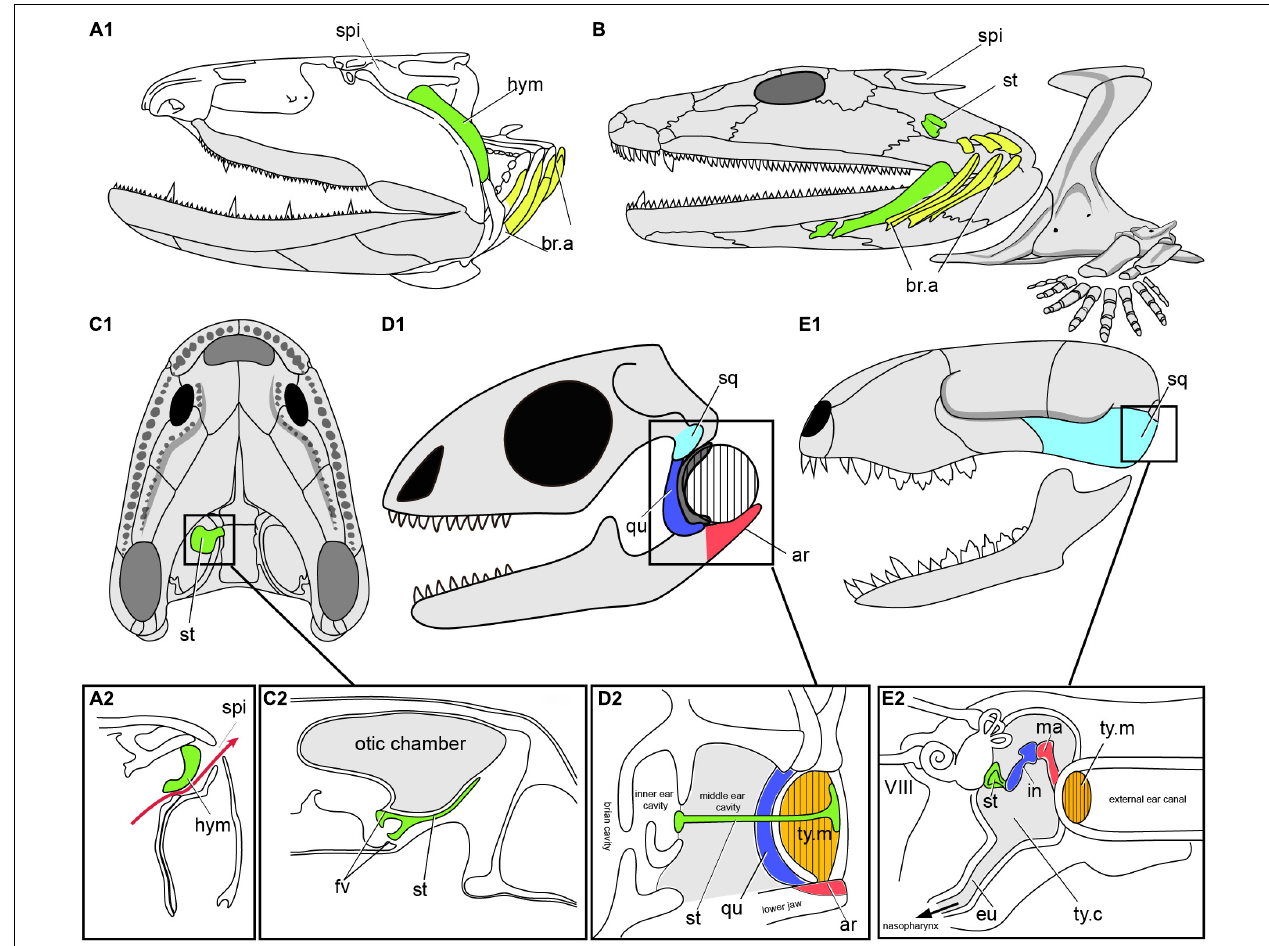
FIGURE 8 | The transition from spiracular pouch of fishes to the middle ear cavity of tetrapods. (A) Fossil osteolepiform Eusthenopteron (A1) , Late Devonian, showing the hyomadibular in the spiracular pouch (A2) , in lateral view, redrawn after (Janvier, 1996b; Brazeau and Ahlberg, 2006). (B) Early tetrapod Acanthostega , Late Devonian of Greenland, showing stapes and the presumed position of the gill arches, in lateral view, redrawn after (Clack et al., 2003; Clack, 2012). (C) Early tetrapod Ichthyostega (C1) , Late Devonian of Greenland, and the reconstructed section (C2) through the air chamber showing its relation to the otic capsule and stapes. (D) Skull of Lizard (D1) , showing the section of middle ear cavity, and the tympanic ear (D2) in reptiles, redrawn after (Clack, 2012). (E) Skull of mammals (E1) , showing the section of middle ear cavity, and the tympanic ear (E2) , redraw after (Farooq et al., 2020). ar, articular; eu, eustachian tube; fv, fenestra vestibuli; hym, hyomandibuar; in, incus; ma. malleus; qu, quadrate; sq, squamosal; st, stapes (columella), ty.c, tympanic cavity; ty.m, tympanic membrane (ear drum); other abbreviations as in Figures 1 , 2